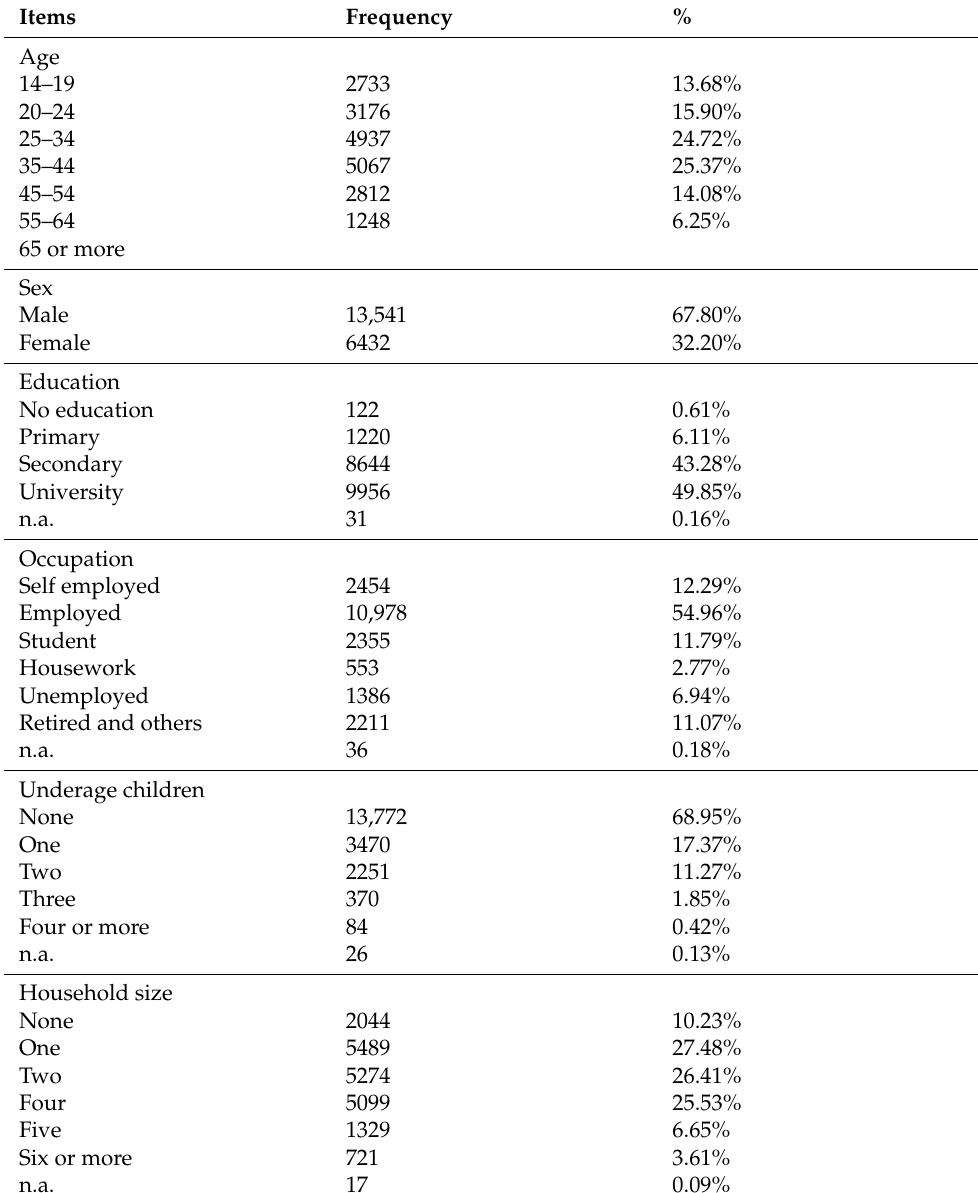
Table 2. Demographic characteristics of the participants ( n = 19,973), 2019.